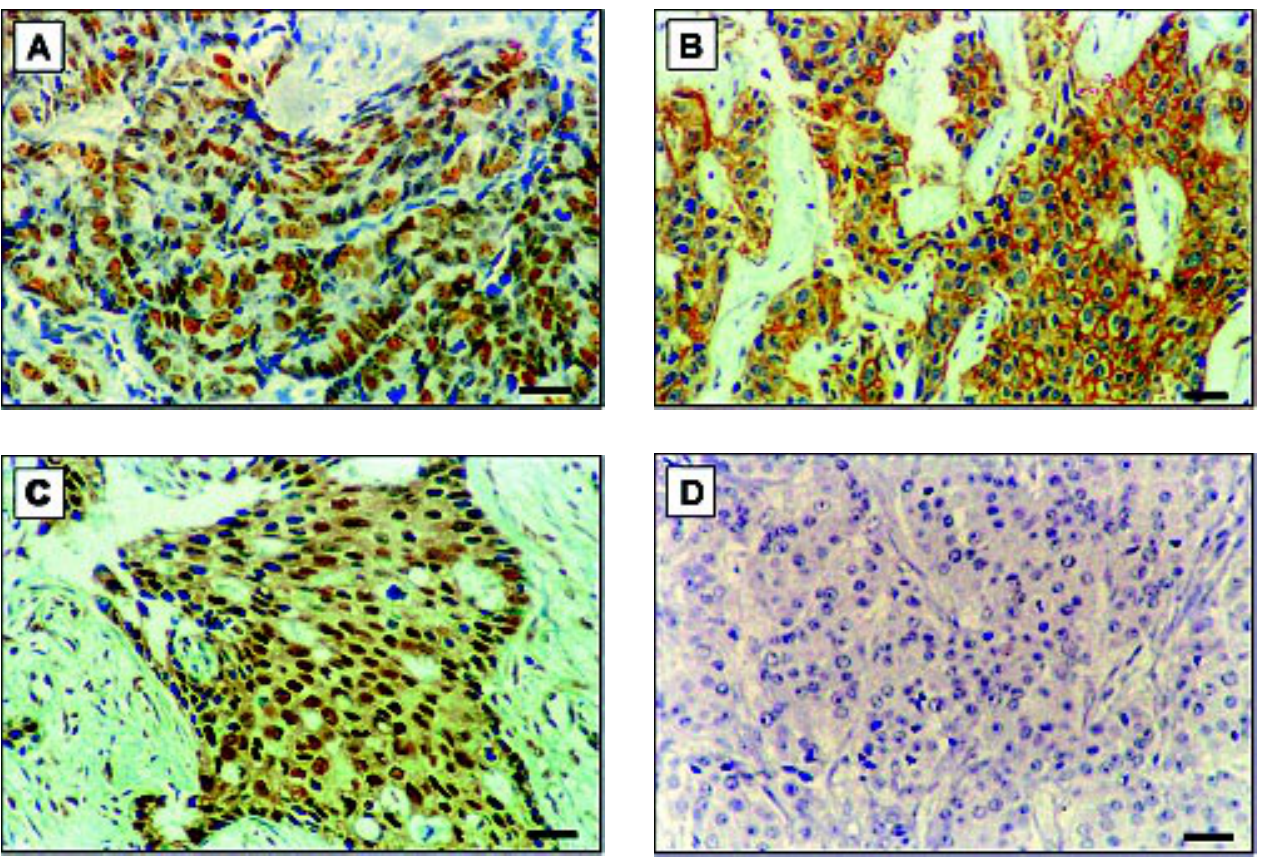
Figure 1. Immunohistochemical detection of p53 (A), c-erbB-2 (B), and c-myc (C) in male breast carcinoma (original magnification 240X). D , Negative control. Bar = 50